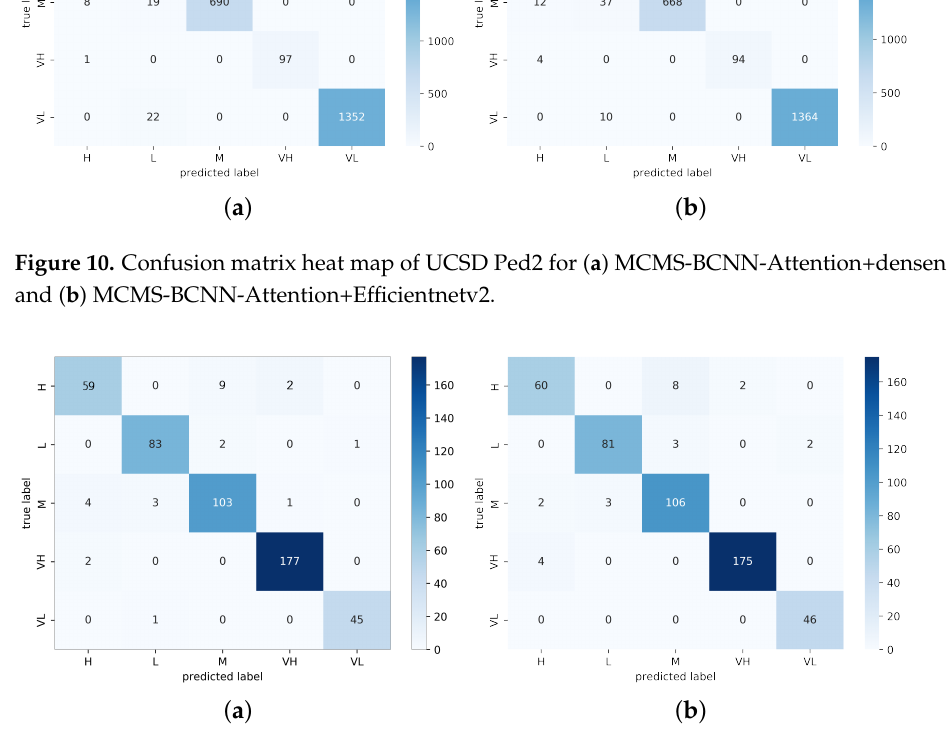
Figure 11. Confusion matrix heat map of PETS2009 for ( a ) MCMS-BCNN-Attention+densenet121 and ( b ) MCMS-BCNN-Attention+Efficientnetv2.